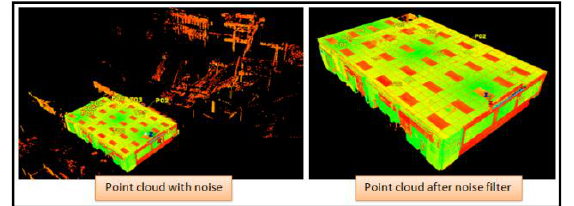
Figure 8. Noise filtering process